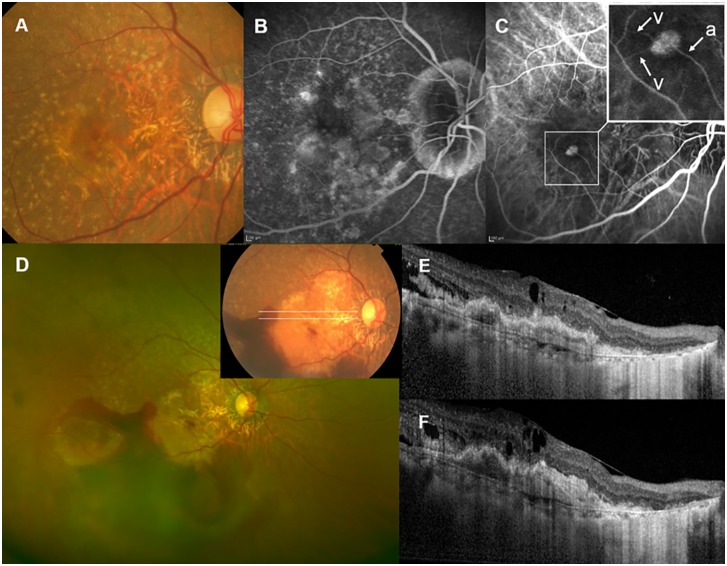
Massive subretinal haemorrhage (SRH) in Patient 11, a 71-year-old woman with retinal angiomatous proliferation (RAP).(A) At baseline, the color fundus photograph showed multiple drusen, retinal hemorrhage, and a neovascular membrane. (B) Fluorescein angiography revealed dye leakage from the neovascular lesion and cystoid changes at the fovea. (C) Mid-phase indocyanine green angiography with magnification (inset). A neovascular complex with retinochoroidal anastomosis composed of a perfusing retinal arteriole (a) and two draining venules (v) was noted. (D) Massive SRH extending past the equator occurred at 21 months after the baseline, and 11 months after the last ranibizumab injection. Best-corrected visual acuity of the right eye decreased from 20/100 to 20/1000. (E) Spectral-domain optical coherence tomography images corresponding to the white lines on color fundus photography (inset of D) revealed intraretinal edema with layered lamellar tissue within fibrovascular tissue under the retinal pigment epithelium.